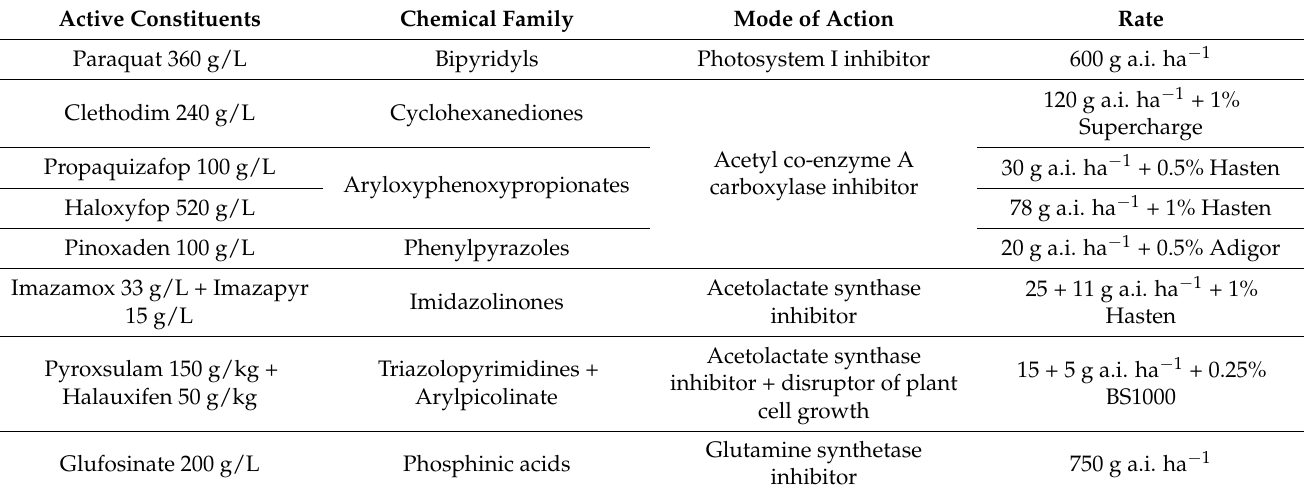
Table 1. Details of the alternative herbicides. All rates are field recommended rates for Lolium rigidum